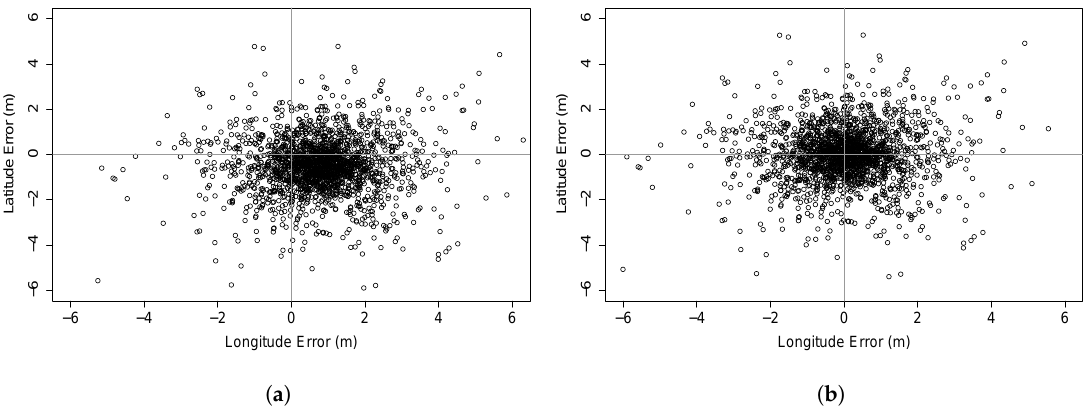
Figure 6. Error simulation comparisons show the FAGPS data has the offset of the centre of the cluster removed. ( a ) Error simulation for non-FAGPS data; ( b ) Error simulation for FAGPS data.